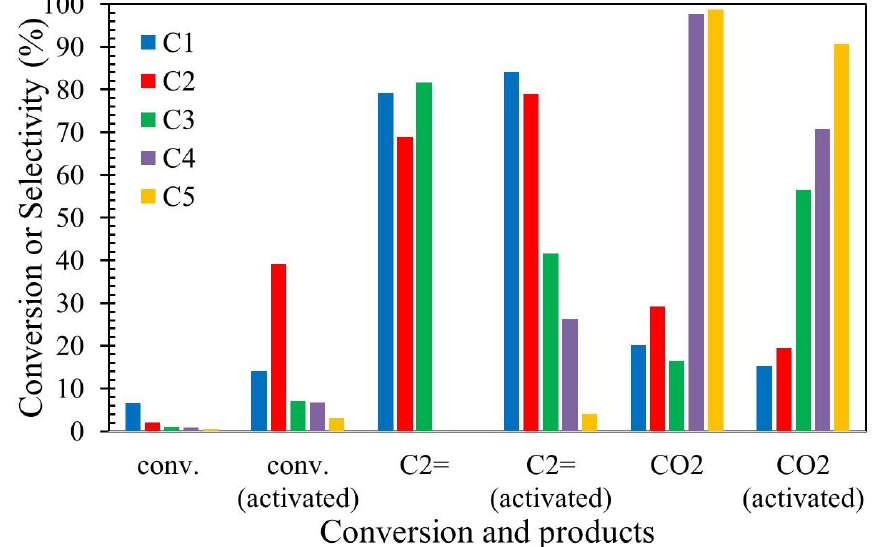
Figure 14. Comparison between the performances (conversion and selectivity to ethylene (C2= and CO 2 ) of neat clays in the study and those of the same clay samples activated by acid in methanol dehydration.